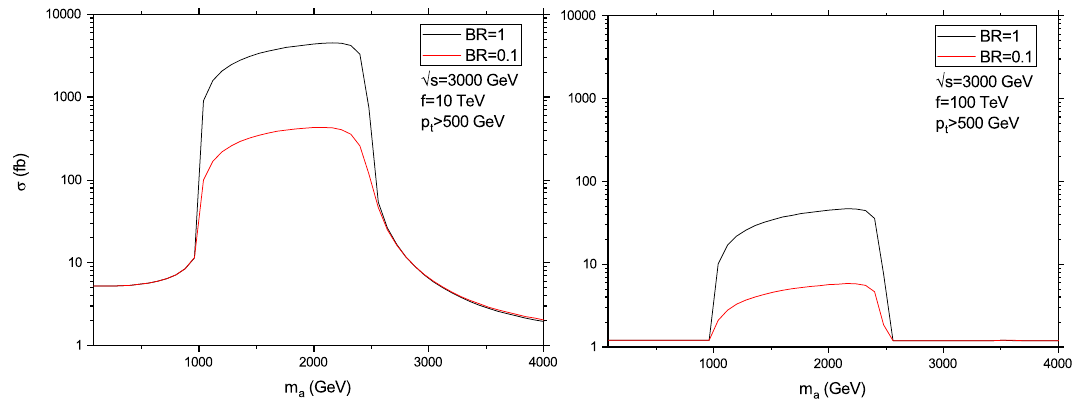
Figure 4 . The total cross sections for the process γγ as functions of the ALP mass m a for f = 10 TeV and f = 100 TeV with two values of Br( a